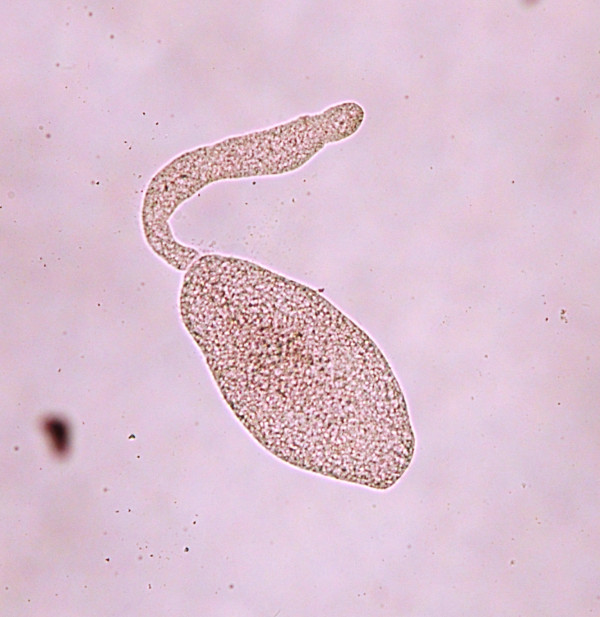
Developmental stage of a metacestode without hooklets.